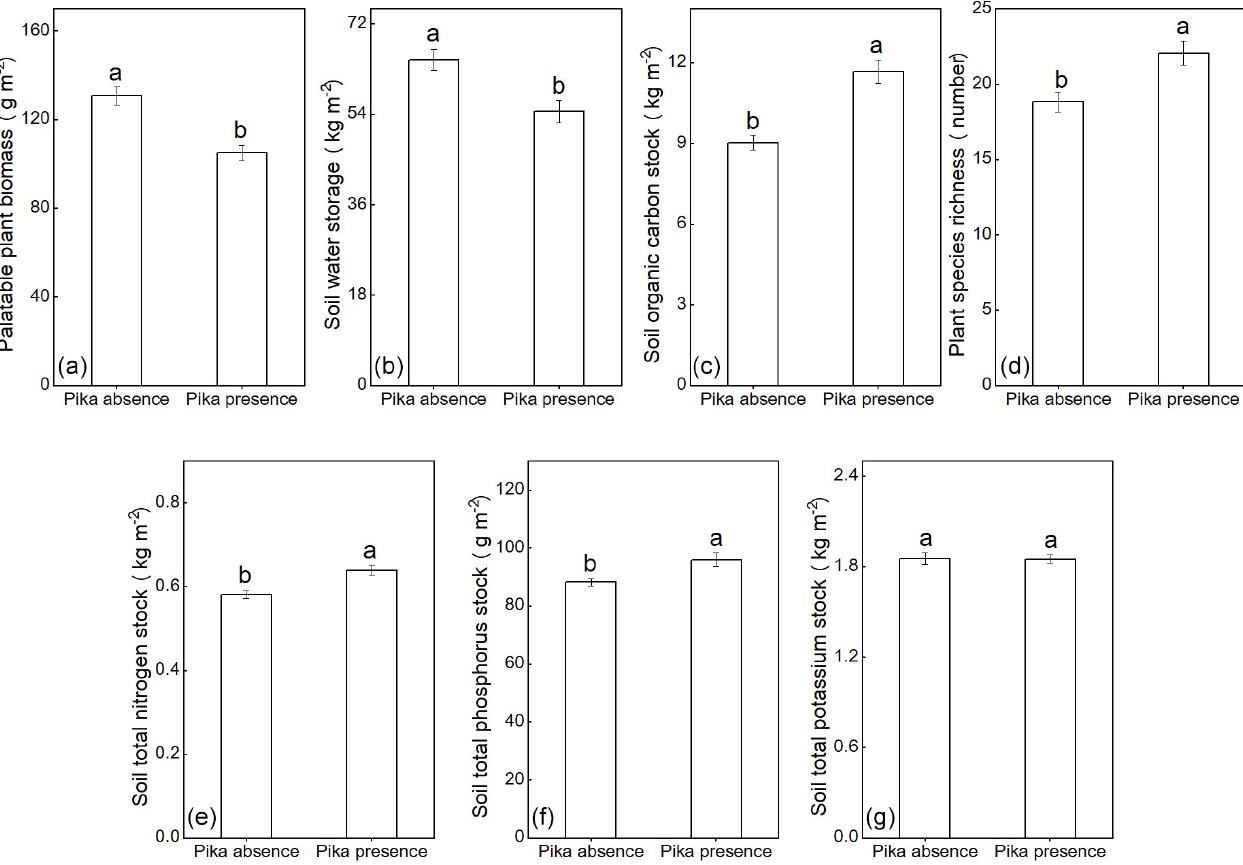
Figure 1. Palatable plant biomass ( F = 46, p< 0 . 001) (a) , soil-water storage ( F = 35, p< 0 . 001) (b) , soil organic carbon stock ( F = 88, p< 0 . 001) (c) , plant-species richness ( F = 64, p = 0 . 003) (d) , soil total nitrogen stock ( F = 22, p< 0 . 001) (e) , soil total phosphorus stock ( F = 12, p = 0 . 004) (f) and soil total potassium stock ( F = 0.03, p = 0 . 88) (g) of plots with and without plateau pikas (mean ± standard error). Lower case represents a significant difference between the absence and presence of pika based on an